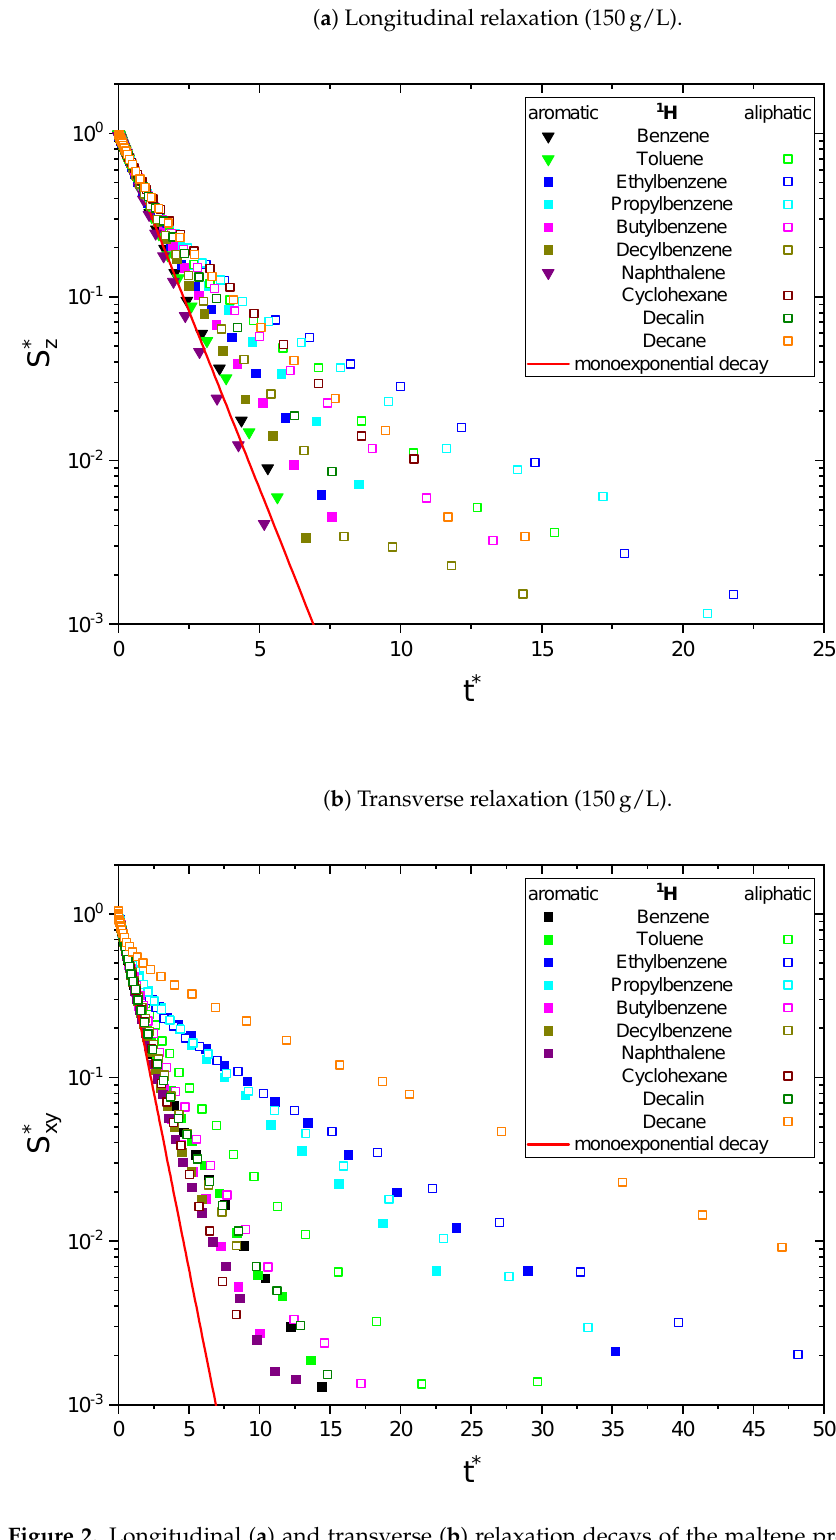
Figure 2. Longitudinal ( a ) and transverse ( b ) relaxation decays of the maltene protons in the as- phaltenic solution, consisting of 95vol% benzene-d 6 and 5vol% of the investigated maltene with additional 150g/L asphaltene. For a qualitative comparison, the time axis is rescaled (see Equa- − 1 ∗ = 0 (see Equations (13) tion (12)) to reflect multiples of R 1,2 , and the signal is normalized to unity at t and (14)). The needed parameters were obtained from a monoexponential ( (cid:79) ) or biexponential ( (cid:3) )